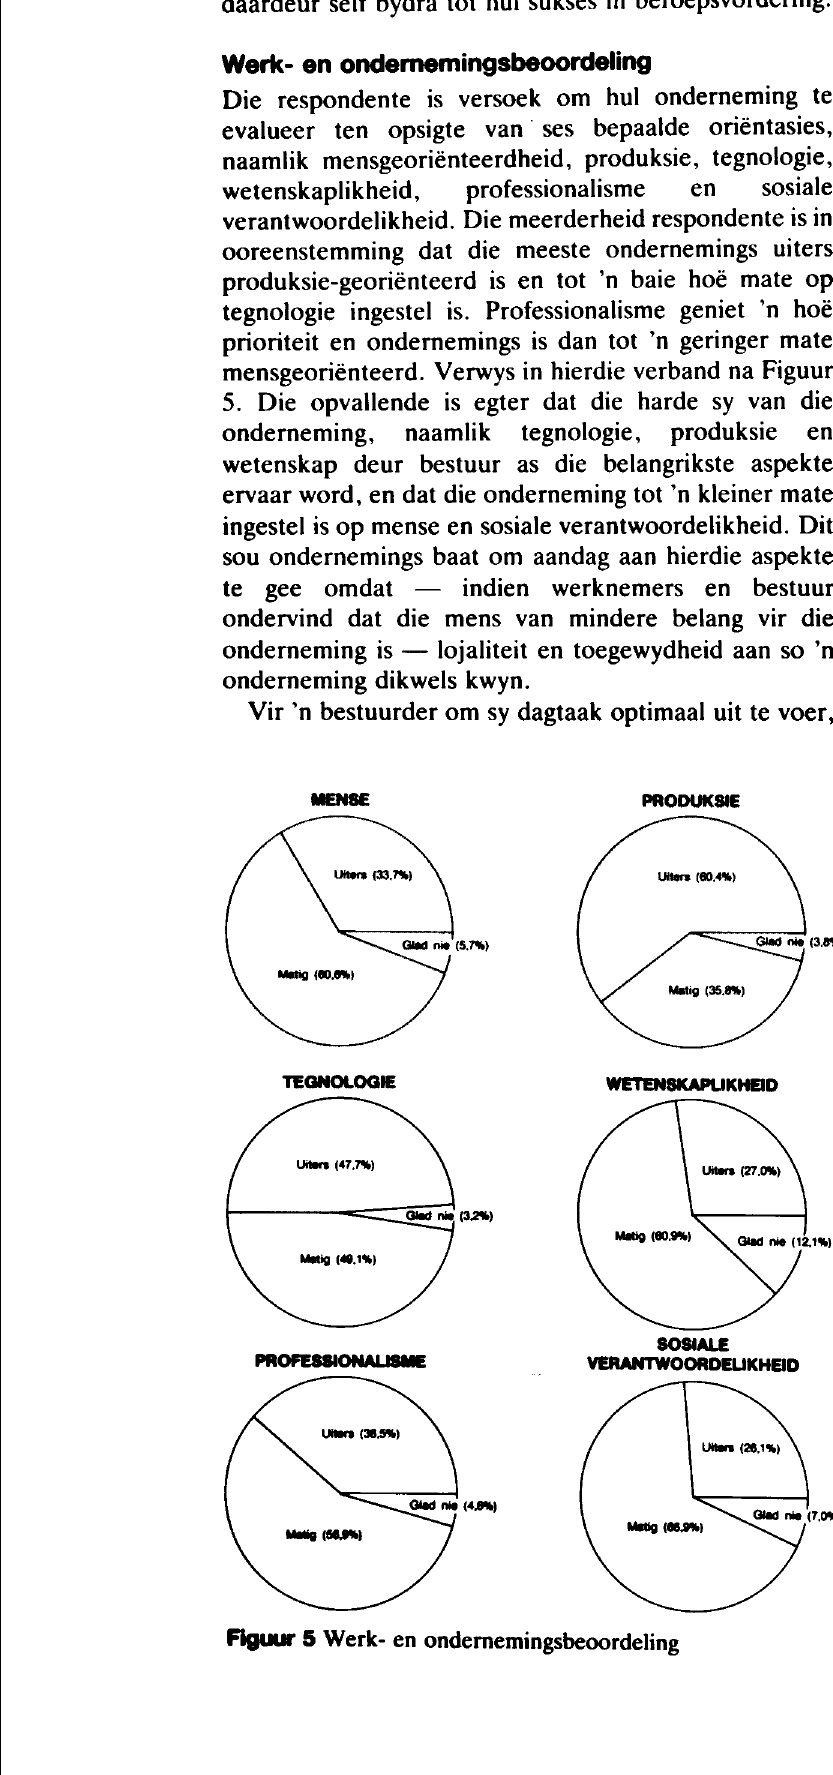
Figuur 6 lnfrastruktuur beoordeling